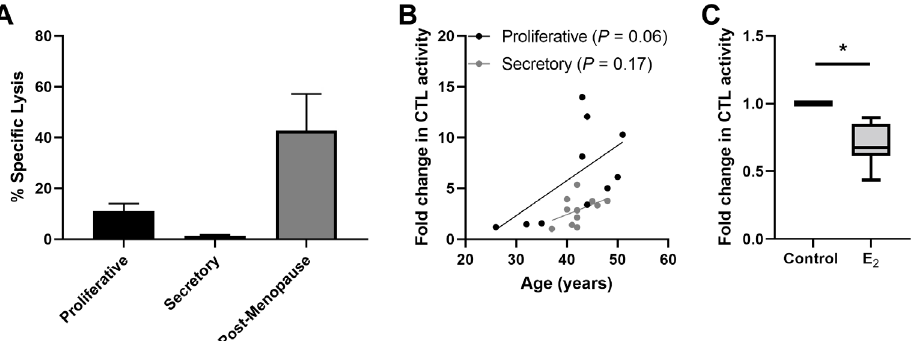
Figure 4. Endometrial CD8+ T cell cytotoxic killing is suppressed in the secretory phase of the menstrual cycle. (A) Redirected lysis assay to measure cytotoxic activity in endometrial mixed cell suspensions showing decreased killing in proliferative and secretory phase and increased killing in postmenopause. Data is derived from White et al. [93]; (B) direct endometrial CD8+ T cell CTL activity trends upwards with increasing age in both the proliferative and secretory phase in pre-menopausal women; (C) 17-β estradiol (E ; 5 × 10 -8 mol/L; 48 h) treatment of endometrial CD8+ T cells suppresses their CTL activity. * P < 0.05. Data in B and 2 C is derived from Shen et al.